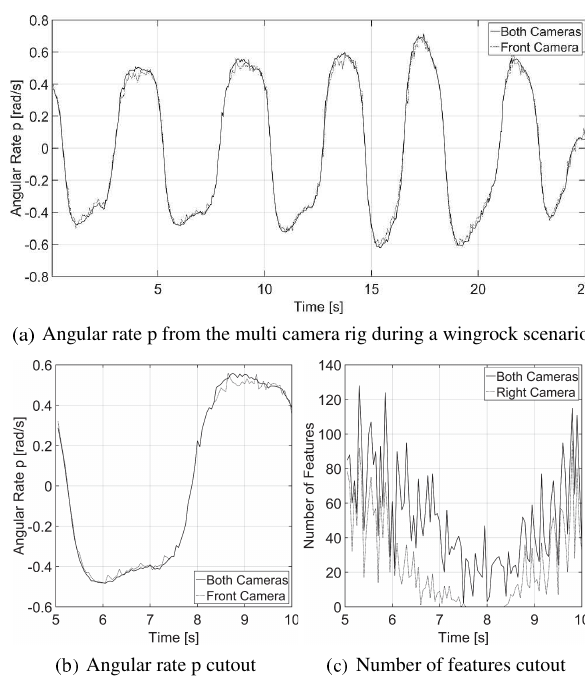
Figure 7: Angular rate of the roll axis calculated from the multi camera rig during a wingrock scenario. Results are shown for the front camera only and both cameras. As shown in the bottom right figure, the influence of the right camera drops if the aircraft banks to the